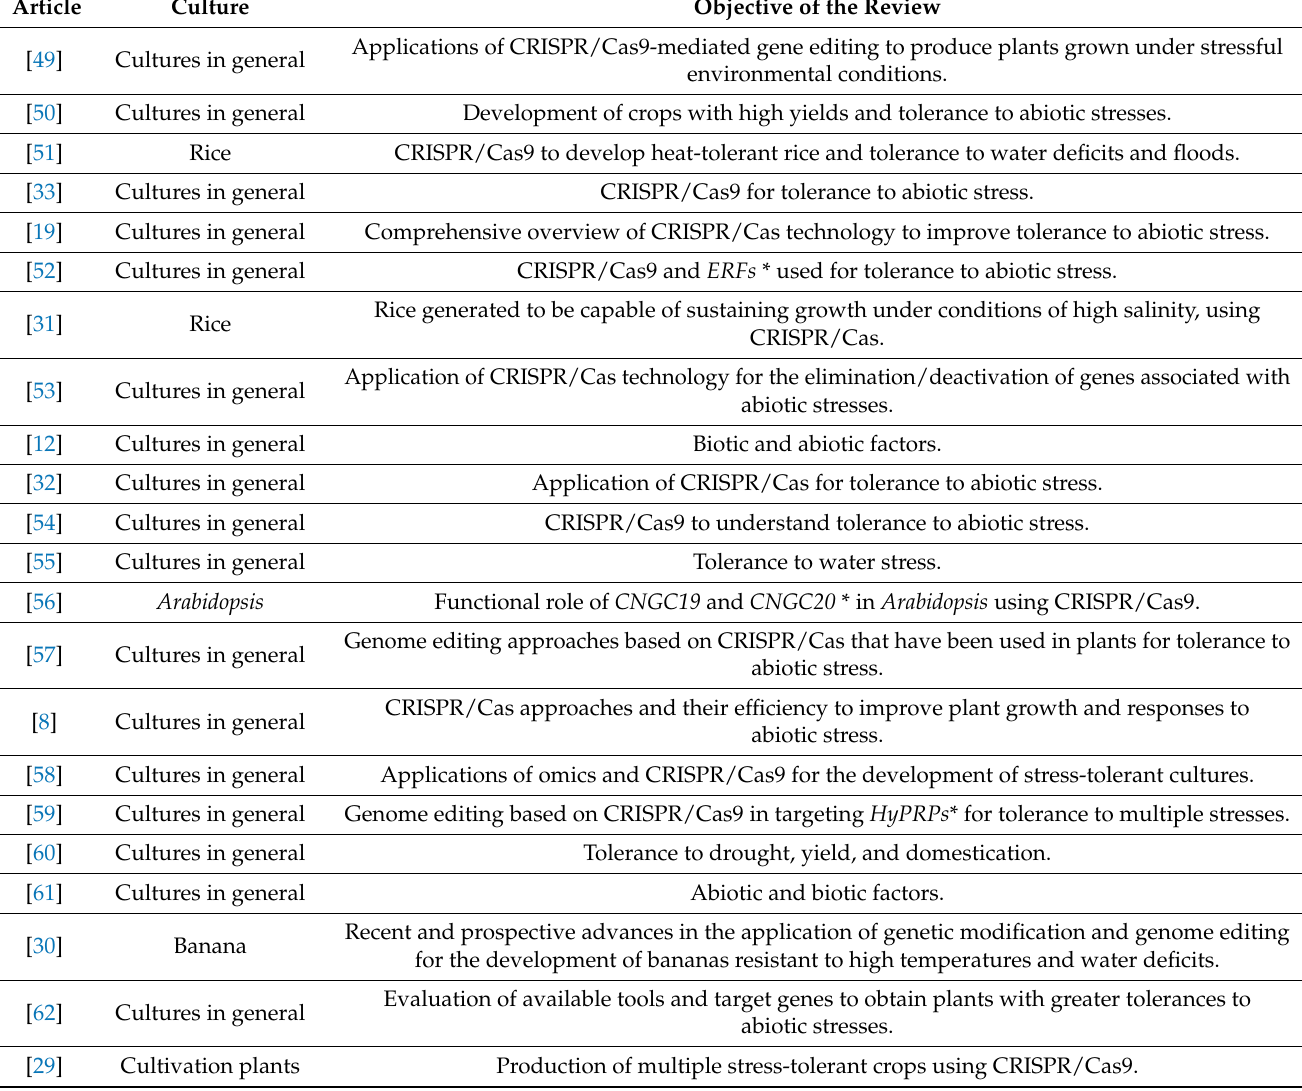
Table 1. Literature reviews published in the last seven years on CRISPR/Cas technology applied to plant breeding with emphasis on abiotic